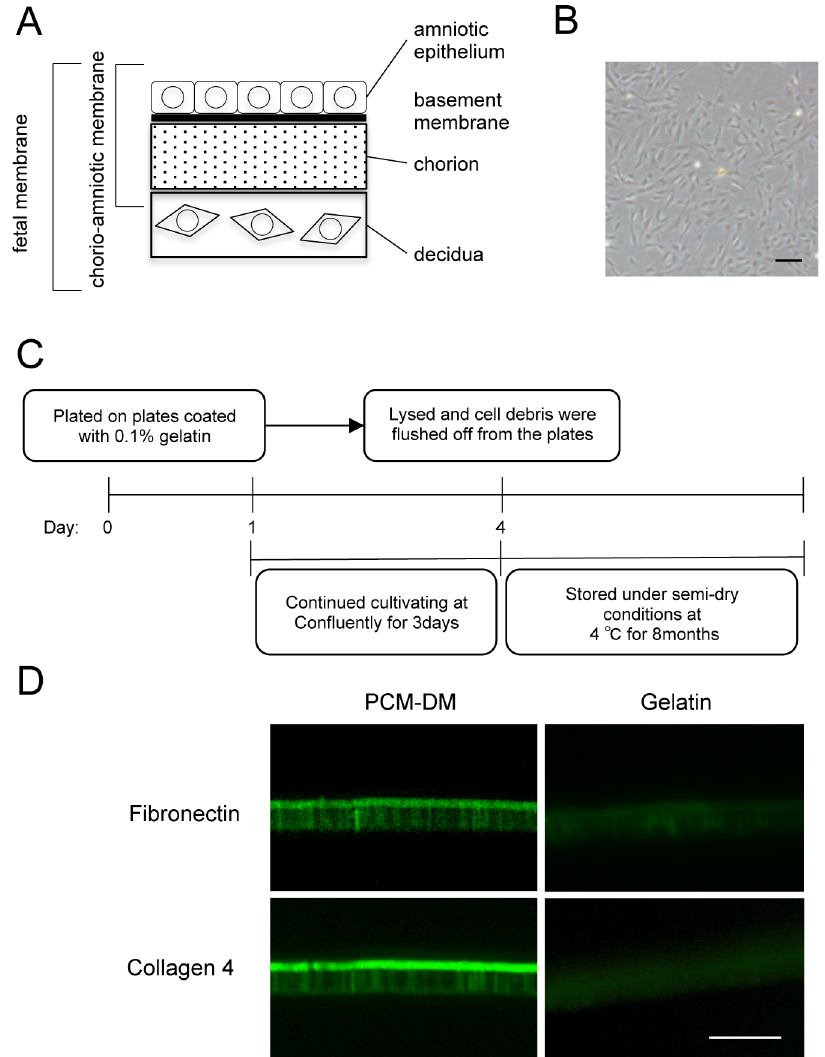
Figure 1. Preparation of pericellular matrix prepared from human decidua-derived mesenchymal cells (PCM-DM) for culture substrate. (A) Schematic of the structure of human fetal membrane (FM). Human FM consists of three main layers: amniotic, chorionic, and decidual membranes. (B) Representative phase-contrast image of human decidua-derived mesenchymal cells (DMCs). The human decidual tissues were isolated from the FMs. The DMCs were isolated from the decidua and cultured with DMEM/F-12 (1:1)-based culture medium supplemented with 10% fetal bovine serum (FBS) (scale bar, 200 m m). (C) The procedure for preparation of the PCM-DM from the DMCs. The DMCs were plated at a density of 3.5 6 10 4 cells/cm 2 onto the culture plate coated with 0.1% gelatin and cultured for 3 days after reaching confluence. They were then lysed